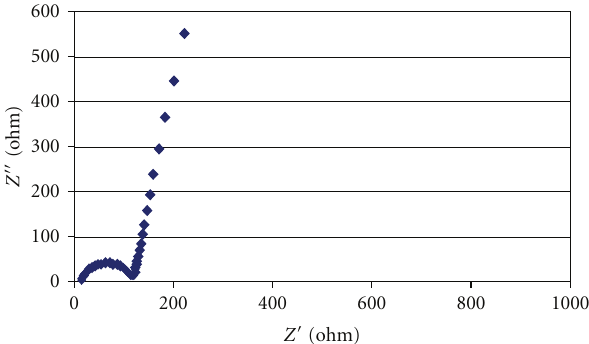
Figure 9: Capacitance as a function of frequency from impedance testing of EDLC CNT-GF/F capacitor cell between 100kHz and 0.02Hz; each carbon electrode has an area of 1cm 2 and mass of